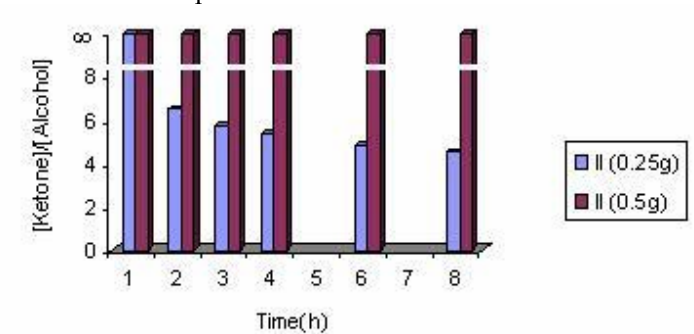
Figure 11. Variation of the [acetophenone]/[1-phenylethanol] ratio vs. time in experiments 2 and 5.